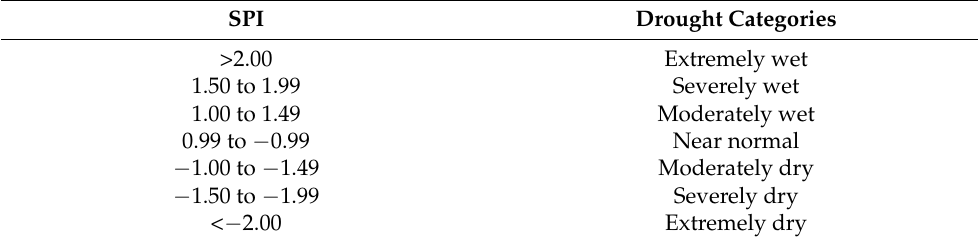
Table 3. Drought event classification based on SPI values [42].